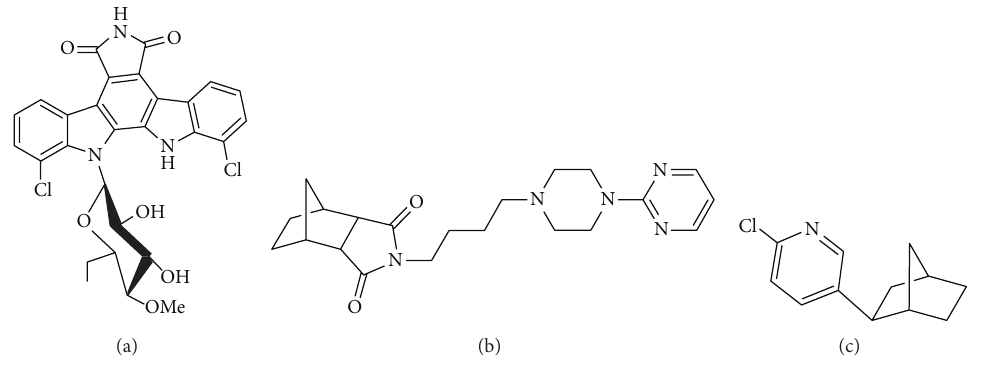
Figure 1: (a) Rebeccamycin, (b) tandospirone, and (c)